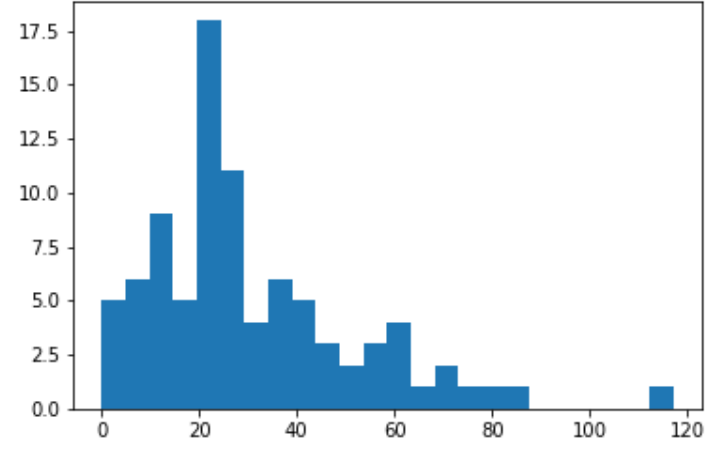
Figure 1: Histogram of response time (in